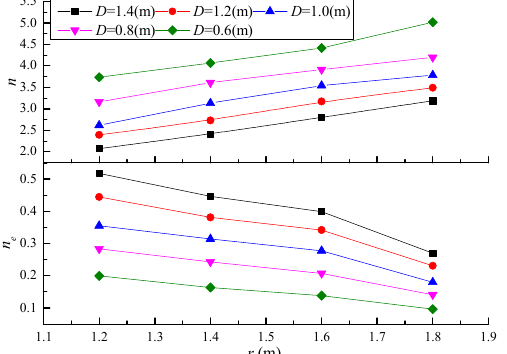
Figure 16. The pile–soil stress ratio and the load sharing ratio vs. r e.